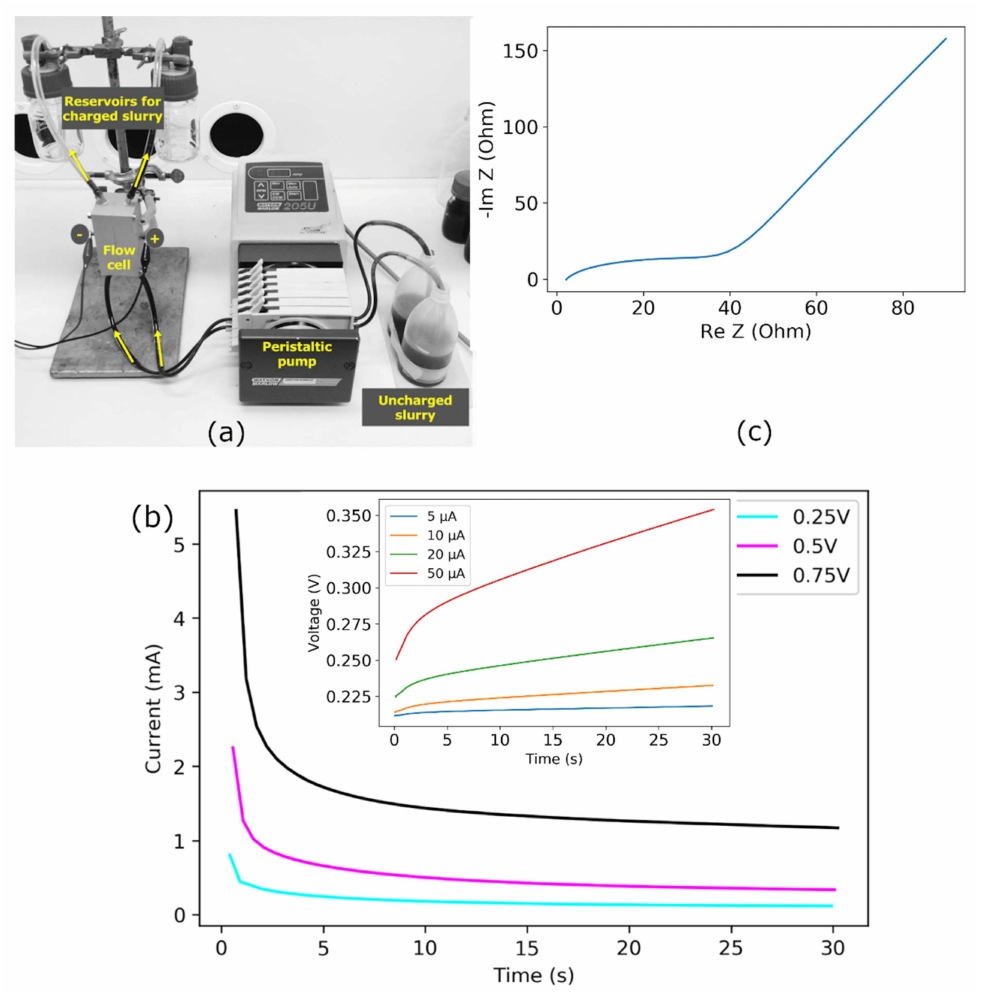
Figure 2. ( a ) Photograph of flow capacitor cell and experimental set-up for charging [49]. ( b ) Poten- tiostatic measurements at constant voltages of 0.25, 0.5, and 0.75 V and (inset) at constant currents of 5, 10, 20, and 50 µ A. ( c ) Nyquist plot for carbon slurry in 0.1 M Na 2 SO 4